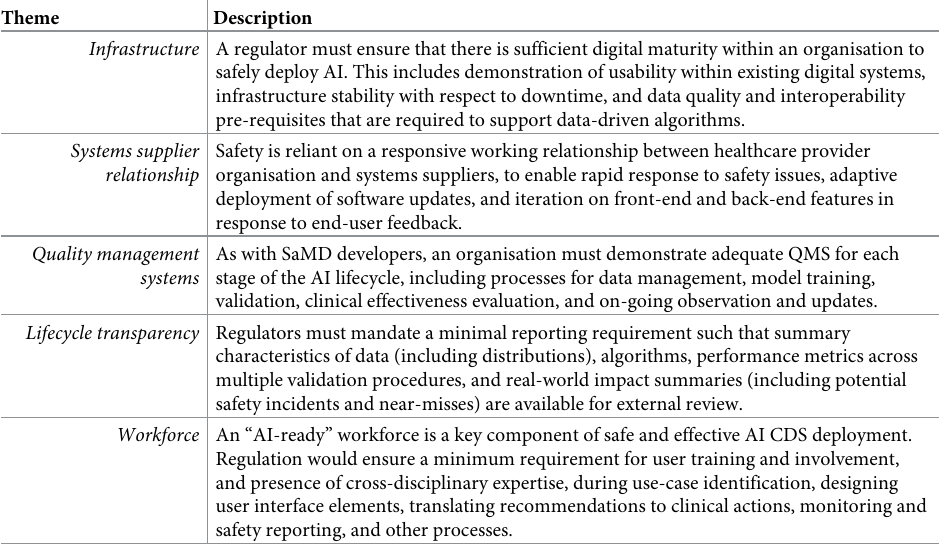
Table 1. Key components of organisation-level regulation. General good practices that may feed into regulation are laid out in the FDA/MHRA joint principles for Good Machine Learning Practice